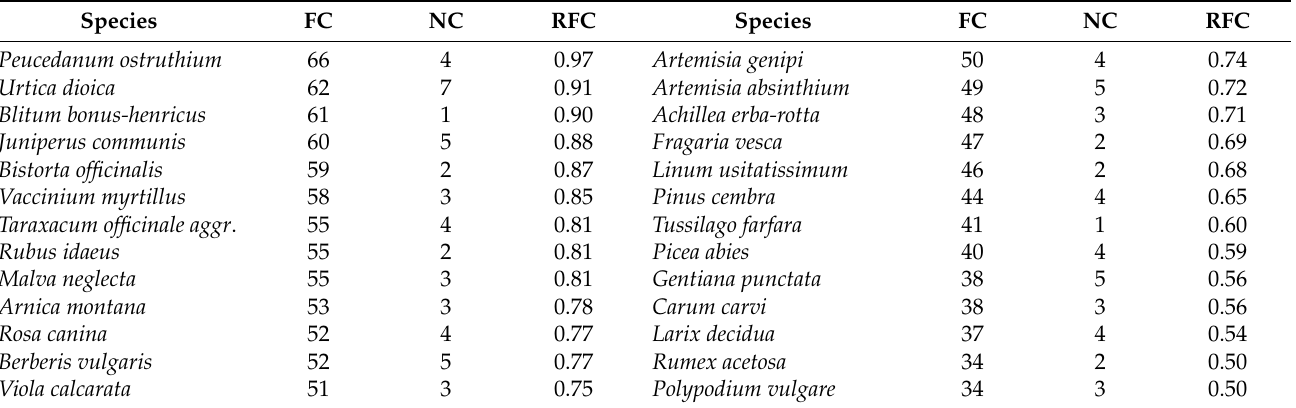
Table 3. Species with a Relative frequency of Citation (RFC) >